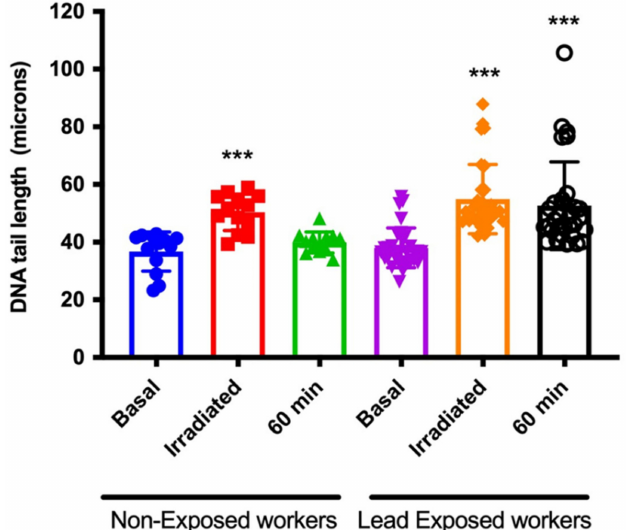
Figure 1. Occupational lead exposure decreases DNA repair capacity . Comet assay was performed from each individual (lead exposed and non-exposed workers), to show basal DNA damage; imme- diately after inflicting DNA damage with ionizing radiation (3Gy) and after 60 min, to determine DNA-repair capacity. Data are means ± S.E of 16 non-exposed and 37 lead exposed workers. One way ANOVA with Tukey HSD pos hoc test was performed with respect to the basal damage of both exposure groups. *** p <